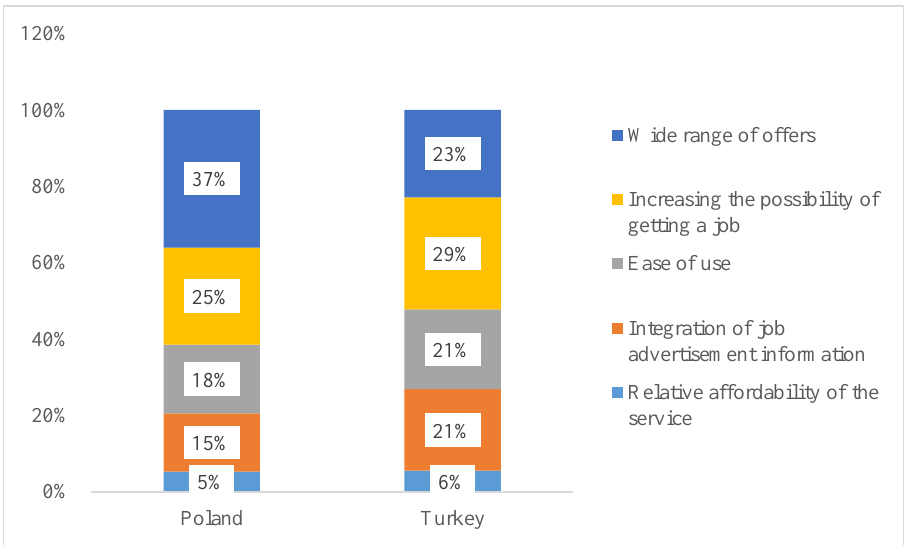
Figure 1. Advantages of HR portals in the opinions of respondents in Poland and Türkiye; Source: own study.